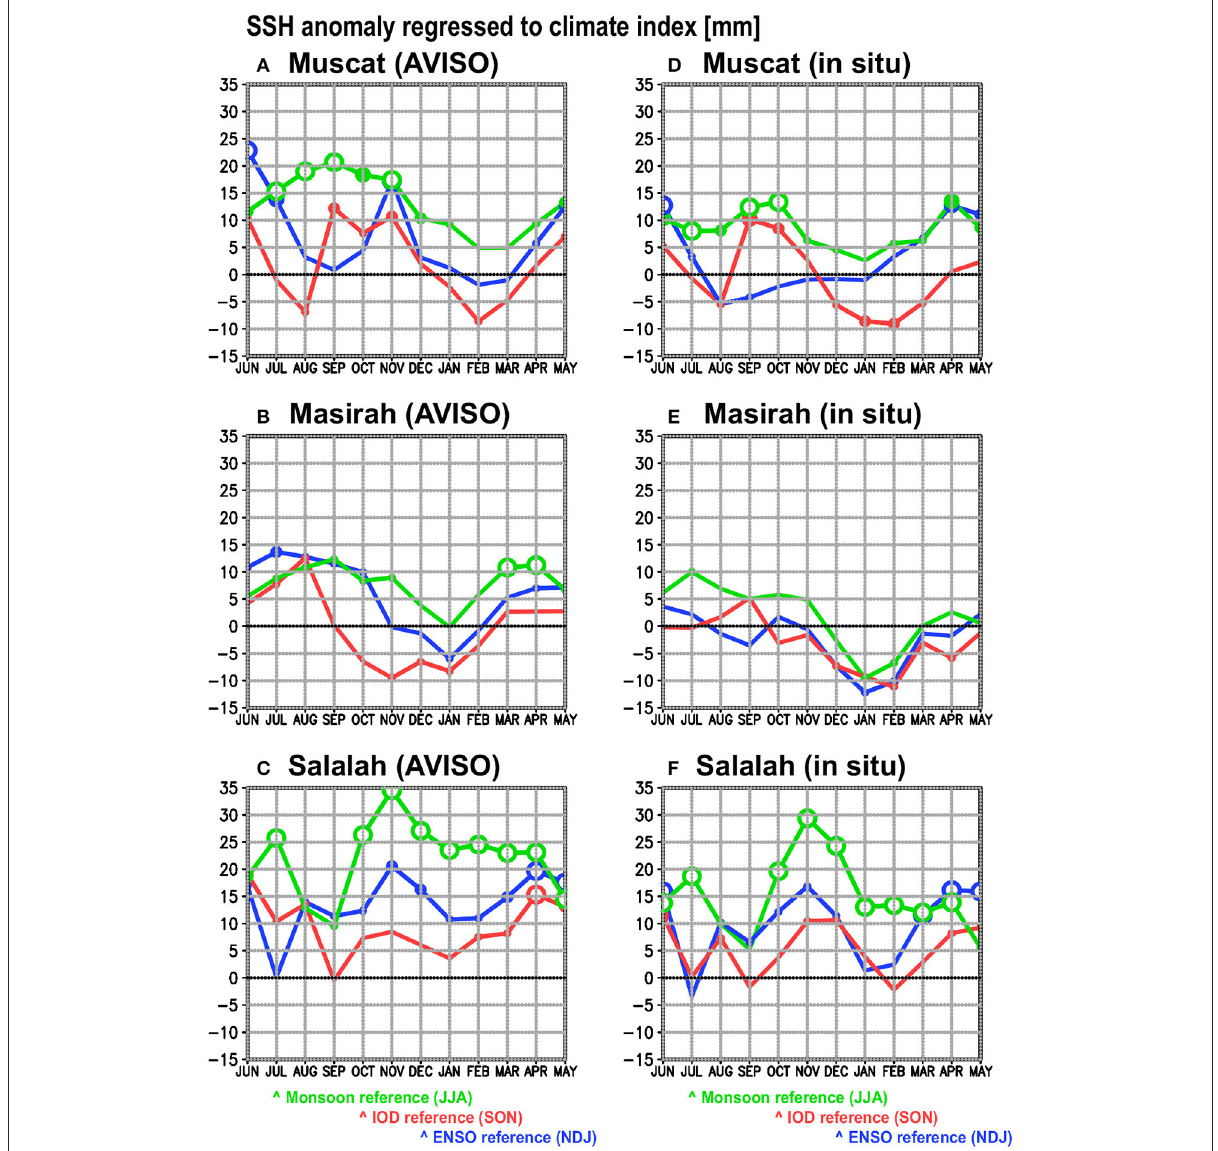
FIGURE4 Lagged regressions of AVISO-derived SSH anomalies to normalized climate indices at the (A) Muscat B, (B) Masirah, and (C) Salalah observatories, respectively. Blue, red, and green lines represent the regressed values of ENSO, IOD, and Indian summer monsoon indices, respectively. Plotted values are 3-month averages with a lag of 0–11 months from the reference month of each climate indices and are calculated using the data in the period when the in situ data are available. White circles indicate that the regression values are significant at a 95% confidence limit in a one-side Student’s t -test. Small, medium, and large colored circles are plotted when the ratio of the regression value to the standard deviation of the observed SSH fluctuation (see right panels of Figure 1) exceeds 0.2, 0.4, and 0.6, respectively. (D–F) Are the same as in (A–C) , respectively, but show the in situ SSH